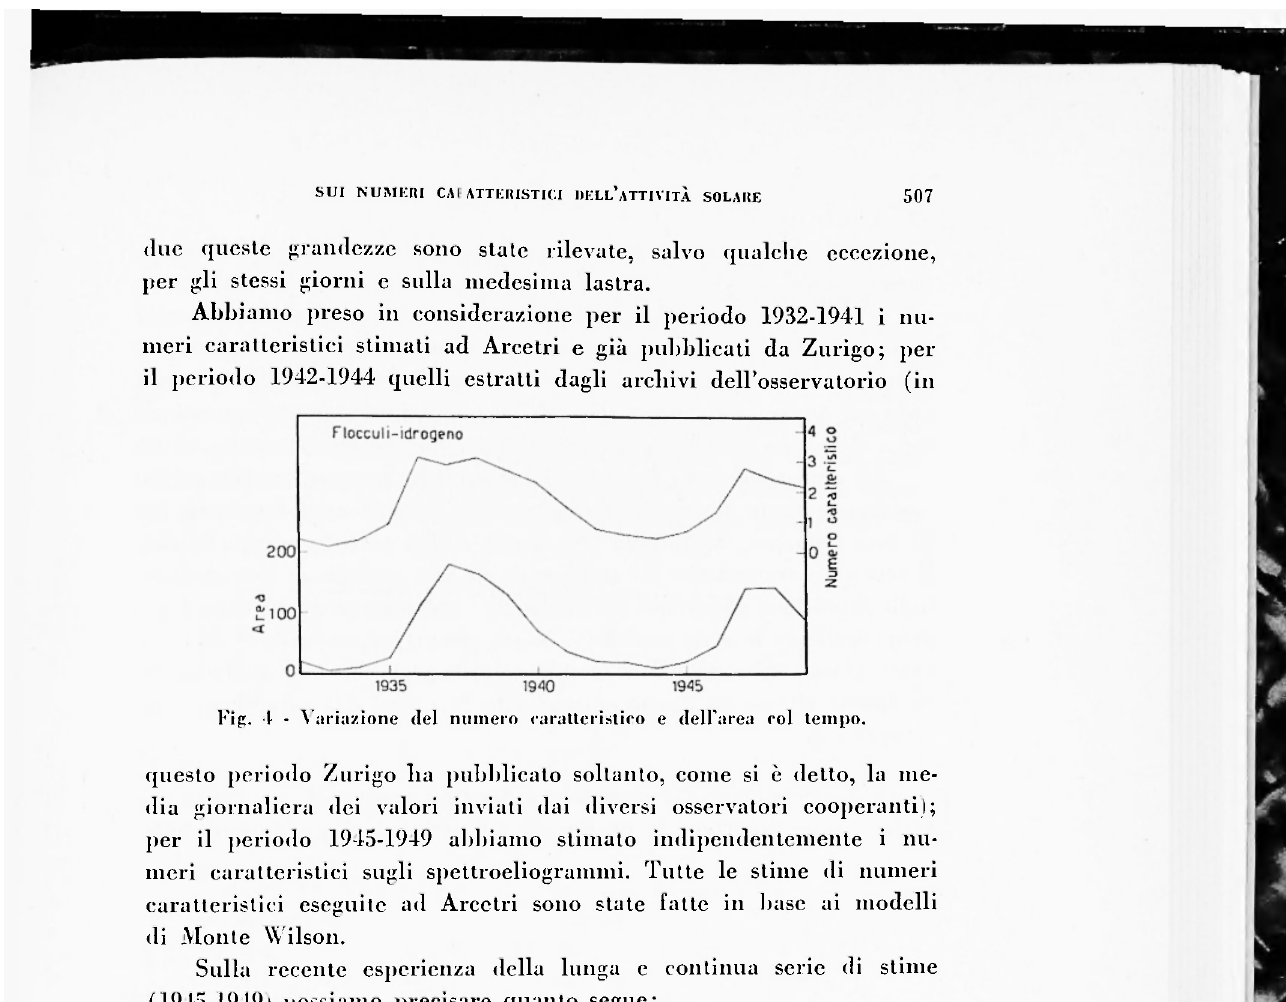
Fig. 1 - \ aria/ione del numero caratteristico e dell'area col tempo. questo periodo Zurigo ha pubblicato soltanto, come si è detto, la me- dia giornaliera dei valori inviati dai diversi osservatori cooperanti); per il periodo 1945-1949 abbiamo stimato indipendentemente i nu- meri caratteristici sugli spettroeliogrammi. Tutte le stime di numeri caratteristici eseguite ad Arcetri sono state fatte in base ai modelli di Monte